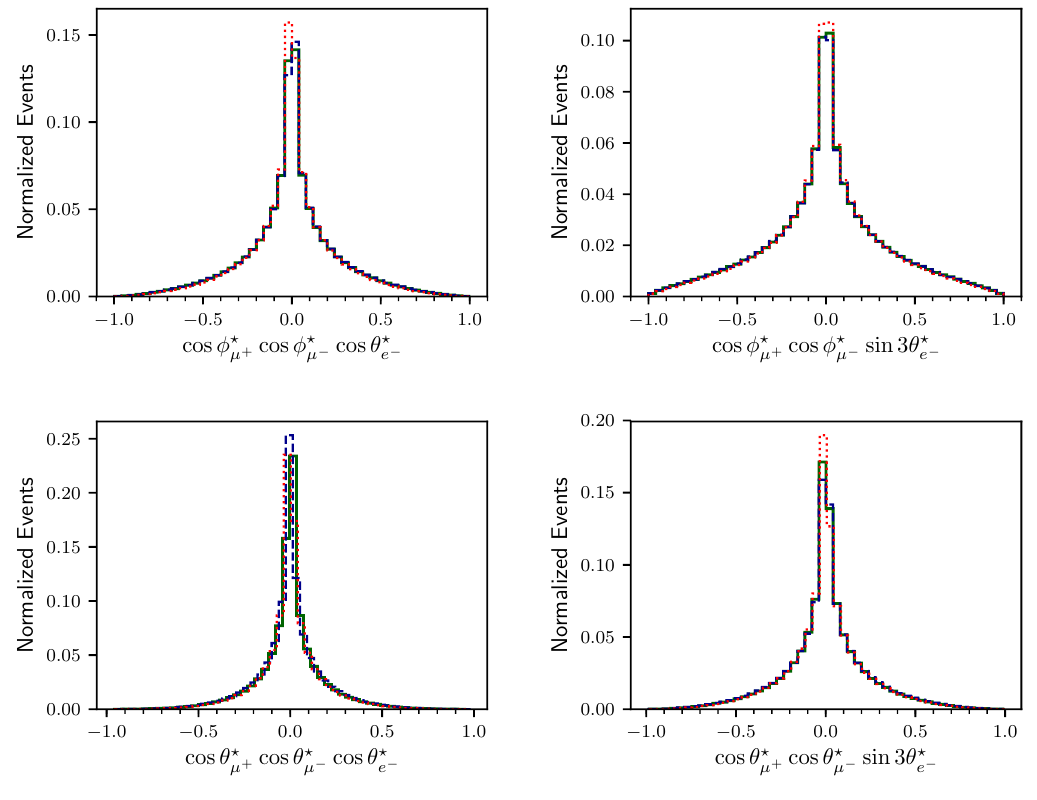
Figure 3 . Normalized distributions of angular functions for three-body ( t ¯ tZ ) spin correlations ( ppT t ¯ tZ in left-top , ppT t ¯ tZ in right-top , ppT t ¯ tZ in left-bottom , and ppT t ¯ tZ in right-bottom xxz zzz xx ( zz ) zz ( zz ) panel) in the rest frame of t , ¯ t and Z for three scenarios namely Parton-Truth , Parton-Reco and Delphes-Reco with the legends same as in figure